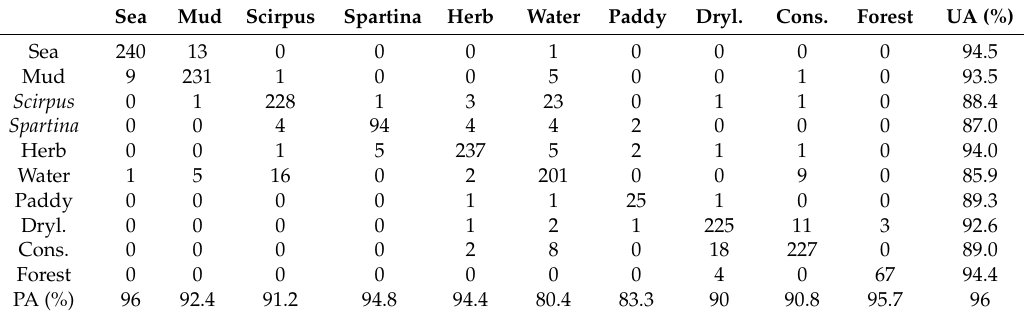
Table 3. Accuracy assessment of wetland classification